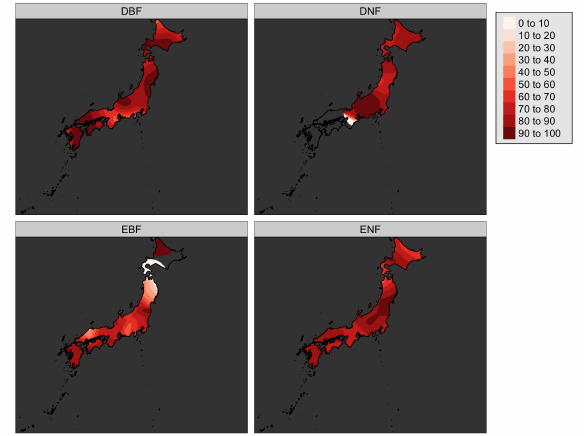
Figure 3. Geographically weighted forest user’s accuracy for DBF, DNF, EBF, and ENF.